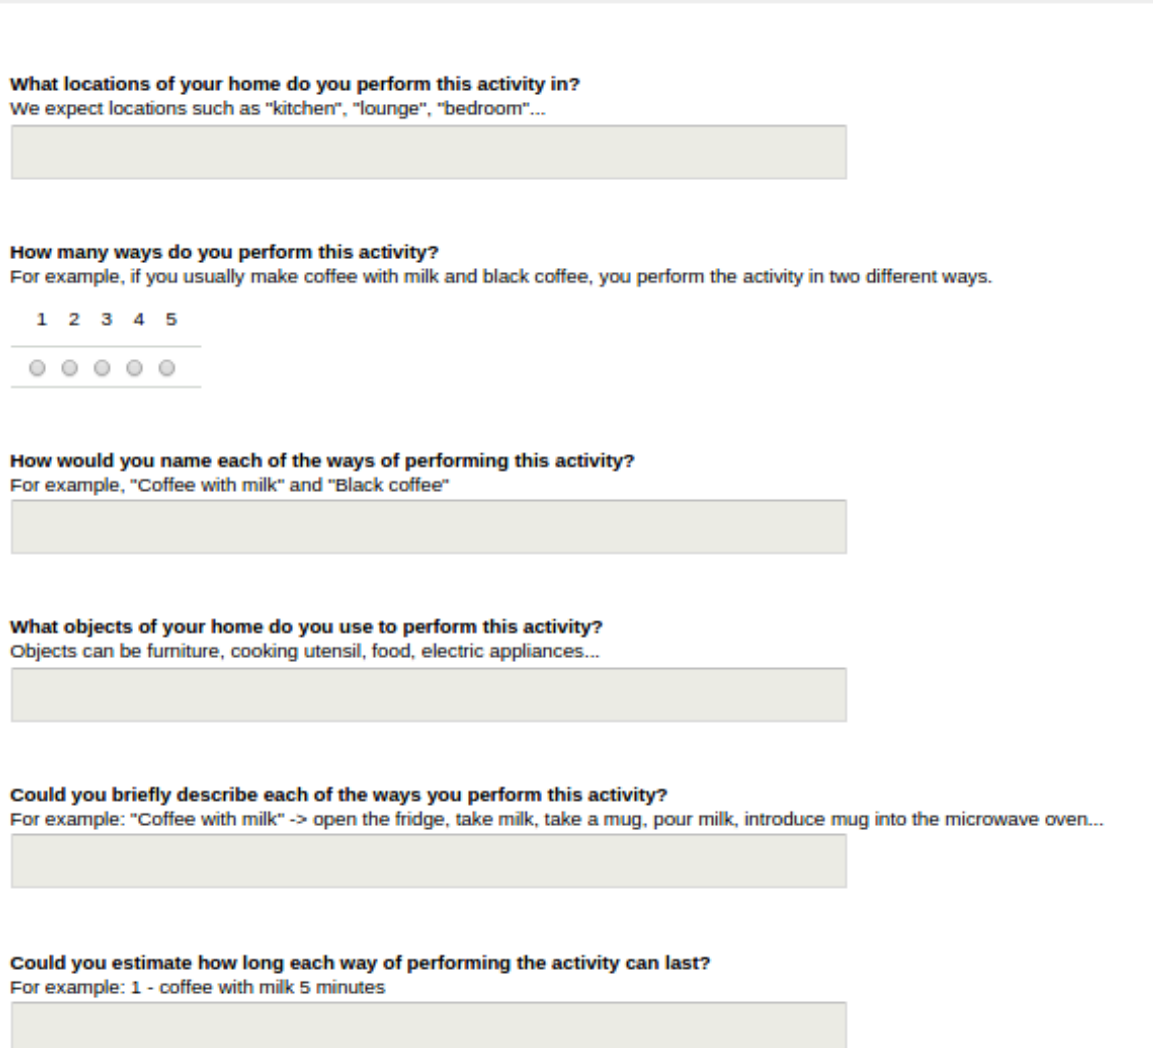
Figure 3. The questions of the survey to capture the activity model of